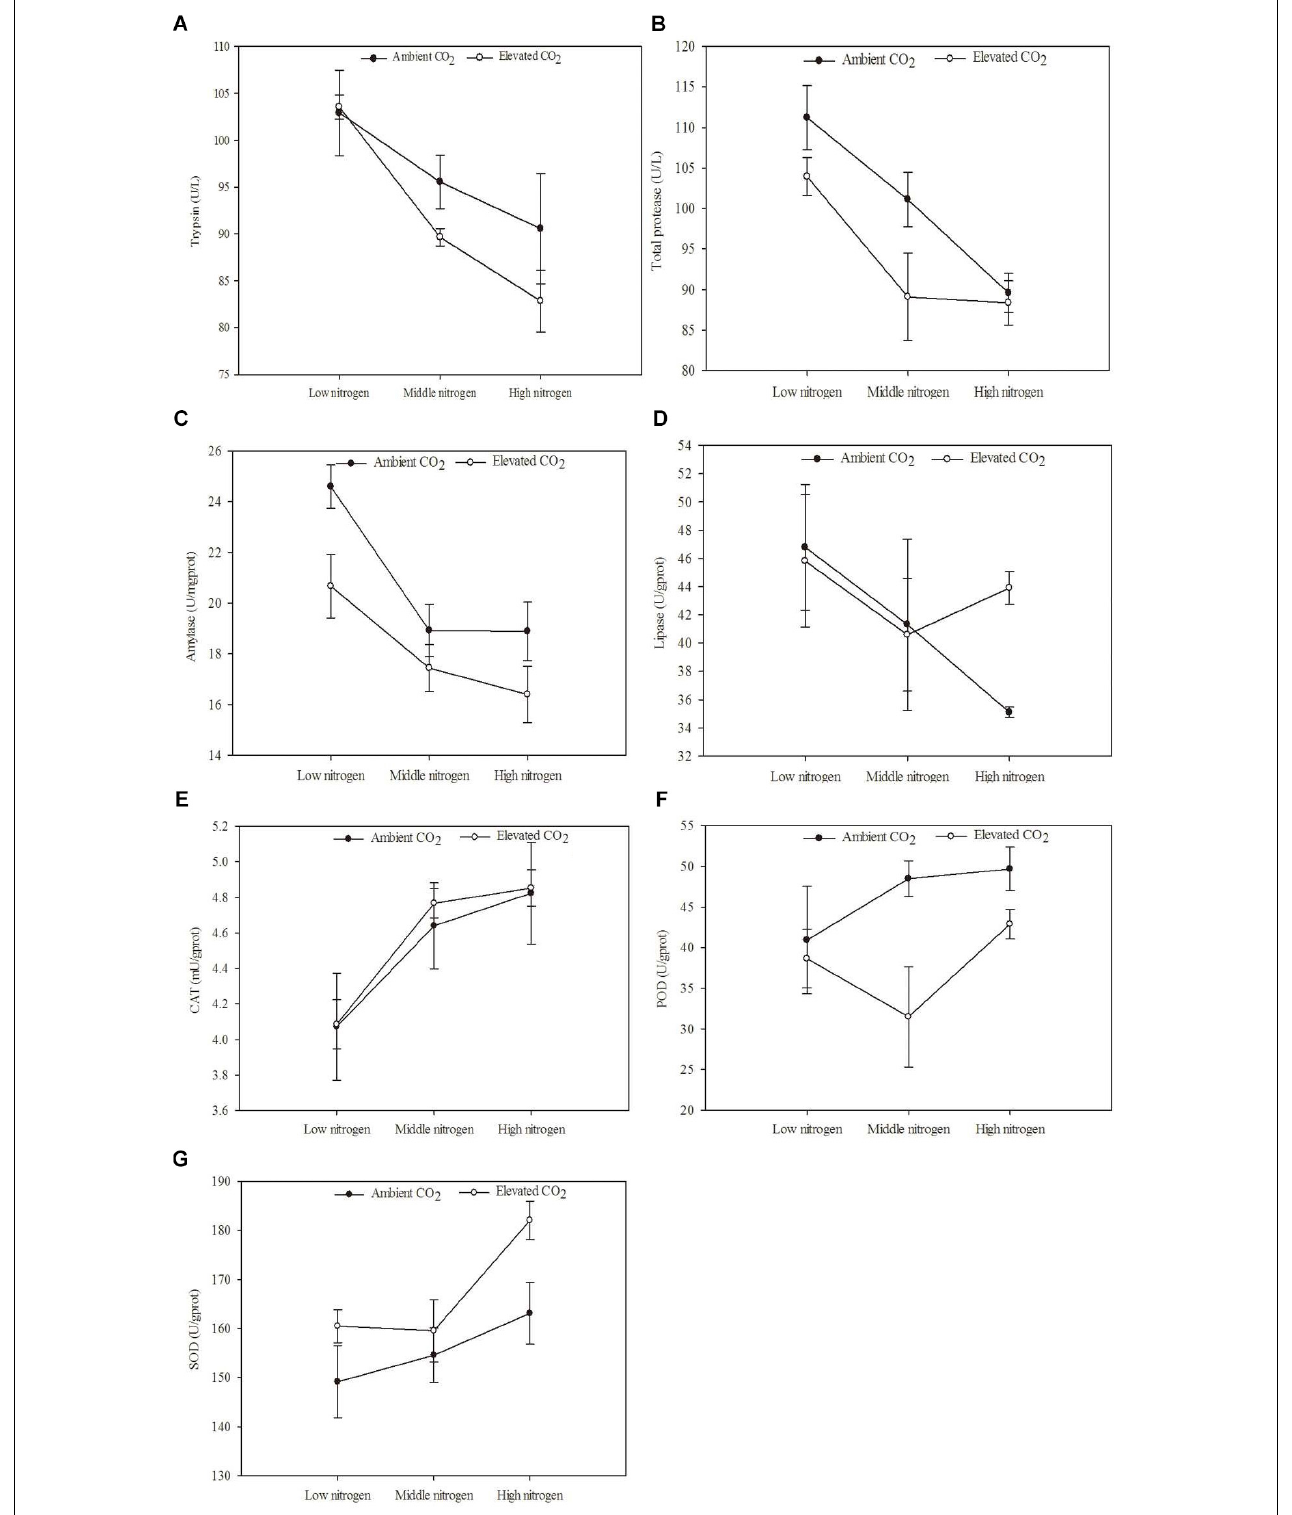
FIGURE 4 | Defense chemical components of Ostrinia furnacalis feeding on maize grown under different levels of CO 2 and nitrogen fertilization conditions (mean ± SE, n = 3). (A) Trypsin activity, (B) total protease activity, (C) amylase activity, (D) lipase activity, (E) catalase (CAT) activity, (F) peroxidase (POD) activity, and (G) superoxide dismutase (SOD)